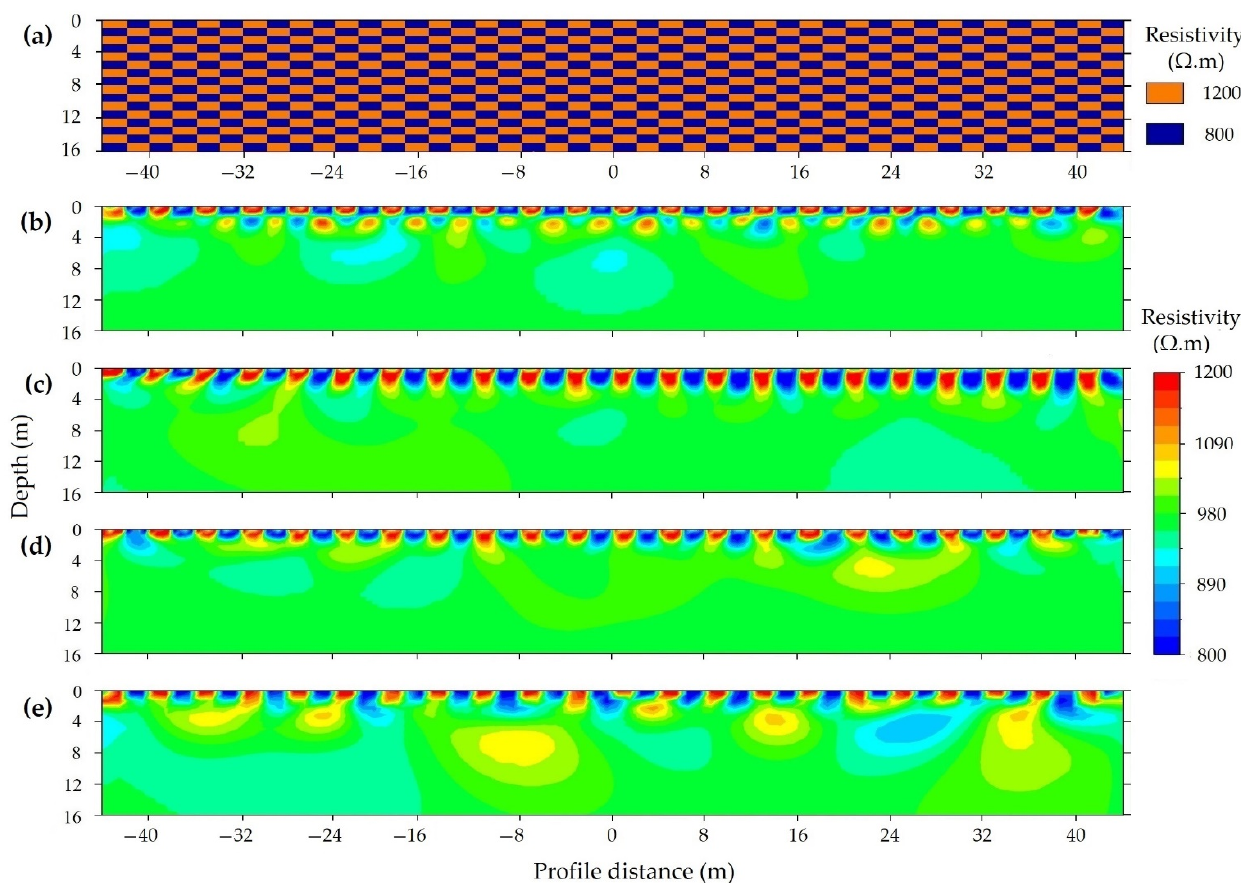
Figure 23. Scenario 1 spatial resolution test for the 1 m (vertical) × 2 m (horizontal) checkerboard cell sizes. ( a ) Checkerboard model, ( b ) DD array, ( c ) PD array, ( d ) WS array, ( e ) PP array.